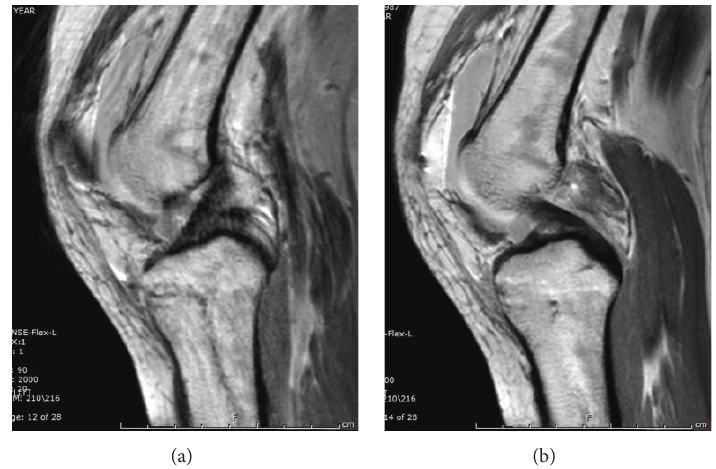
Figure 3: Initial sagittal MRI scans showing intact anterior cruciate ligament (a) and posterior cruciate ligament